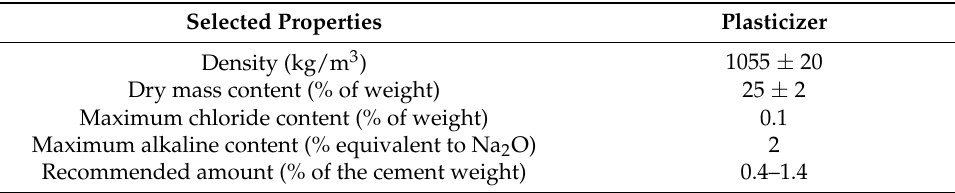
Table 3. Selected properties of the plasticizer STACHEMENT 2180.1.